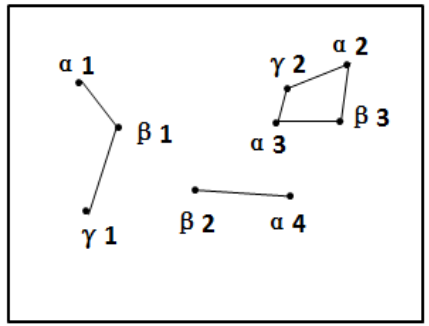
Figure 1. Co-location mode diagram